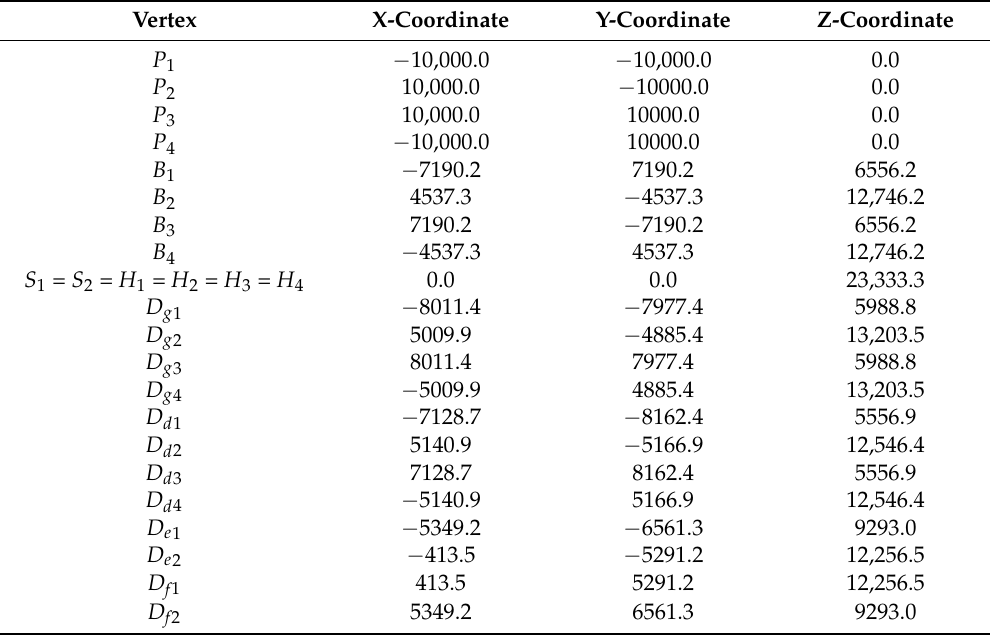
Figure 27. Selected points and lines characterizing the general form of the discussed free form. Table 3. Parameters achieved for the examined architectural free form from Figure